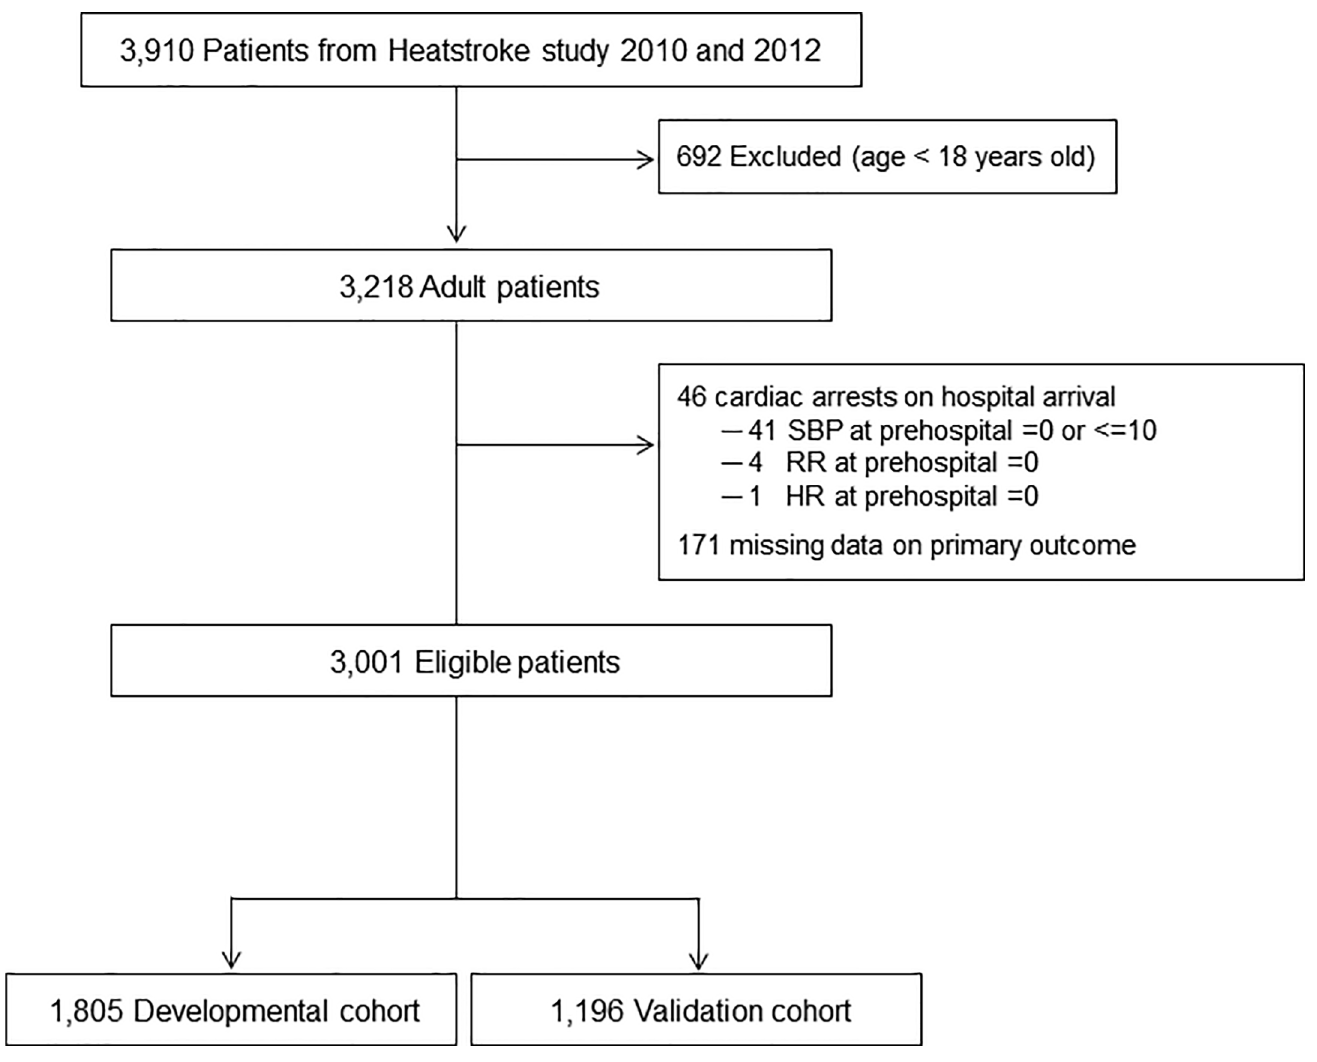
Fig 1. Patient selection. https://doi.org/10.1371/journal.pone.0197032.g001 PLOS ONE | https://doi.org/10.1371/journal.pone.0197032 May 9,